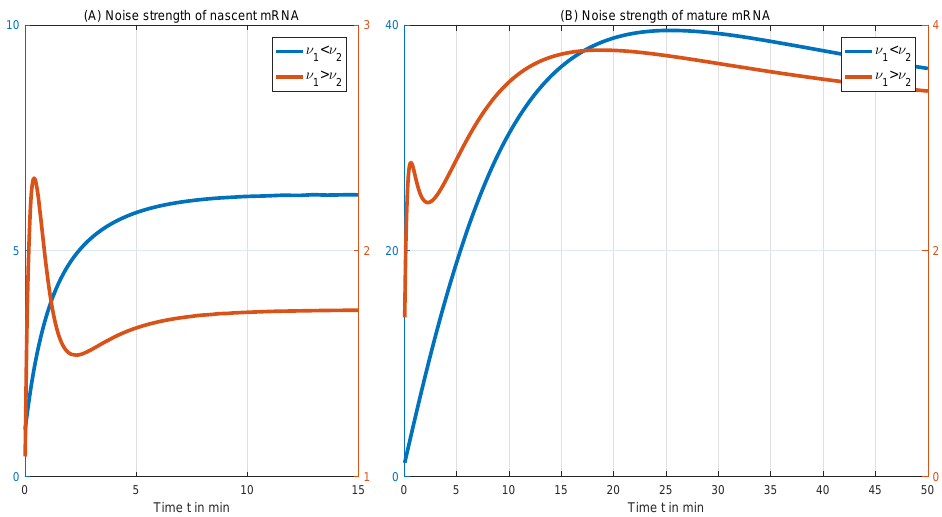
Figure 6. ( A ) Noise strengths of nascent mRNAs for cases ν 1 < ν 2 and ν 1 > ν 2 ; ( B ) noise strengths of mature mRNAs for cases ν 1 < ν 2 and ν 1 > ν 2